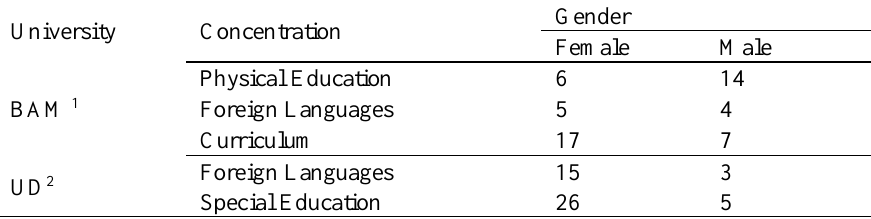
Sub-sample of fourth-year students, according to university, concentration and